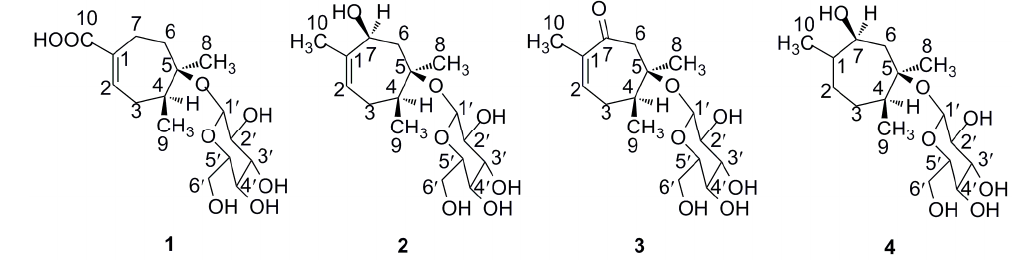
Figure 1. Structures of compounds 1 – 4 .